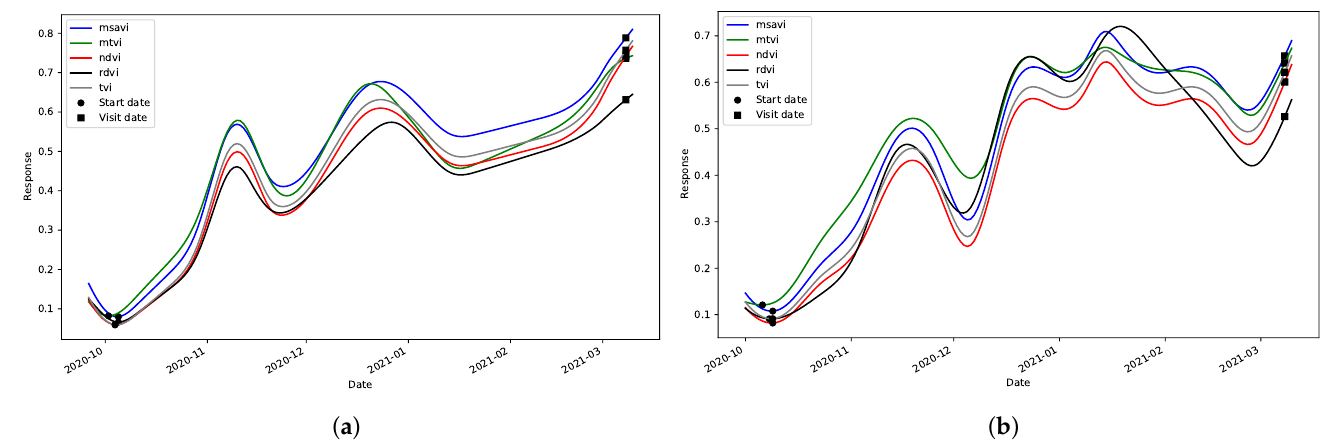
Figure 8. Planet Dove satellite image data time-series plots of the average vegetation index response across one of the grassland ( a ) and woodland ( b ) field site plots; the start and end points of the time-series measure of pasture persistence are also indicated in each plot.